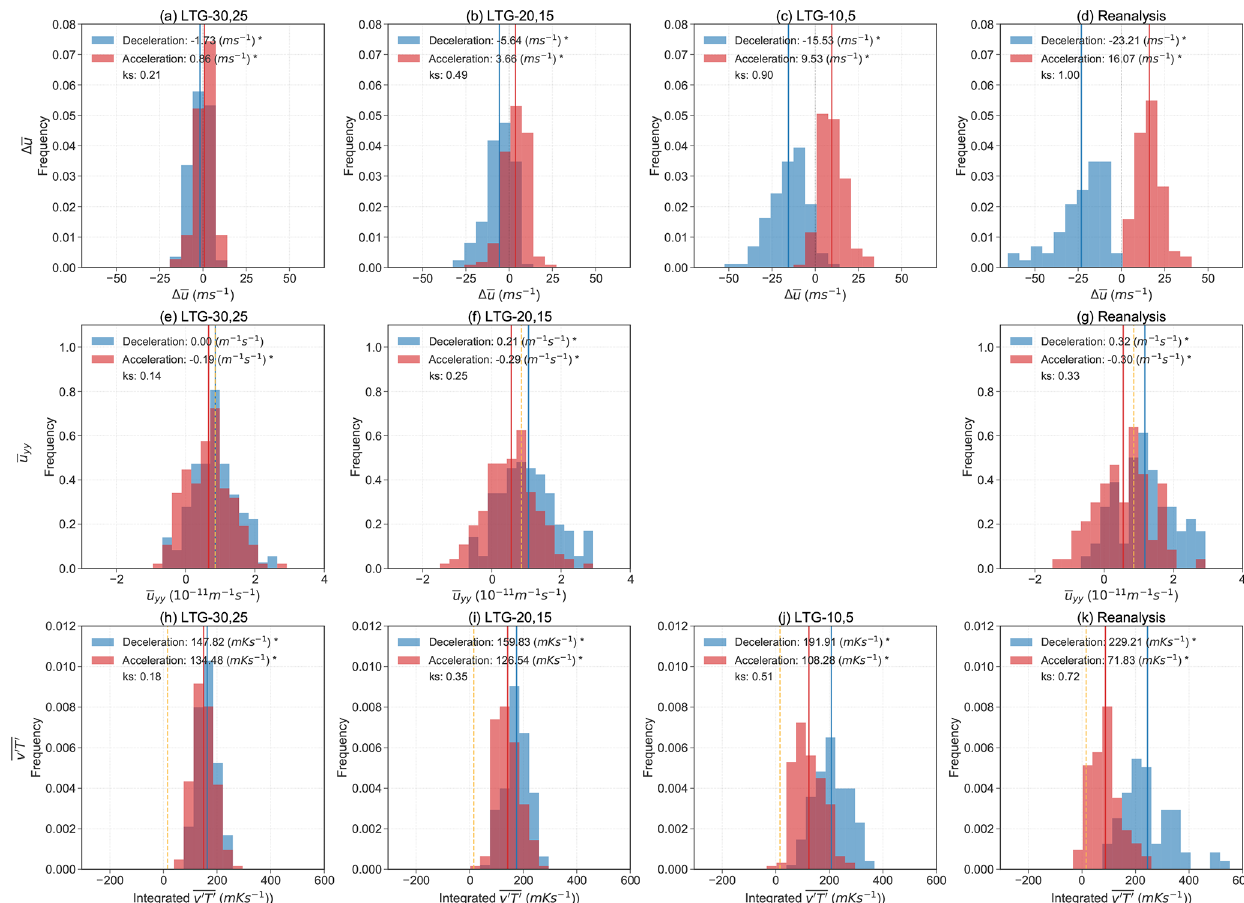
Figure 8. Ensemble mean values of (cid:49)u (a–c) , u yy averaged over days − 10 to − 1 (e, f) and integrated v (cid:48) T (cid:48) over days 0 to 9 (h–j) predicted by the model for the events diagnosed in reanalysis at different lead times. The observed distributions from reanalysis are shown in panels (d) , (g) and (k) . Deceleration events are shown in blue and acceleration events in red. The winter climatological values of u yy and integrated v (cid:48) T (cid:48) from reanalysis are plotted as dotted yellow lines. The differences of the mean of the distributions from 0 (for (cid:49)u ) or from climatology (for u yy and integrated v (cid:48) T (cid:48) ) are shown in the legend. “ ∗ ” indicates when the distributions are significantly different from 0 in (a)–(d) and when the distributions differ from the reanalysis climatological value in (e)–(l) using a t test. The histograms are normalised, and a KS test is used to test the significant difference between the acceleration and deceleration event distributions. KS statistics (ks) are all statistically